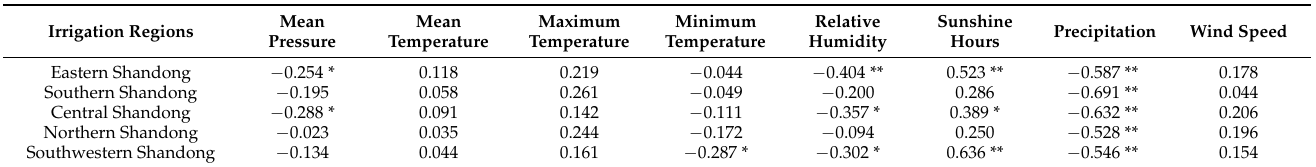
Table 5. Correlation coefficients and significance between irrigation water requirements of summer maize and meteorological factors.